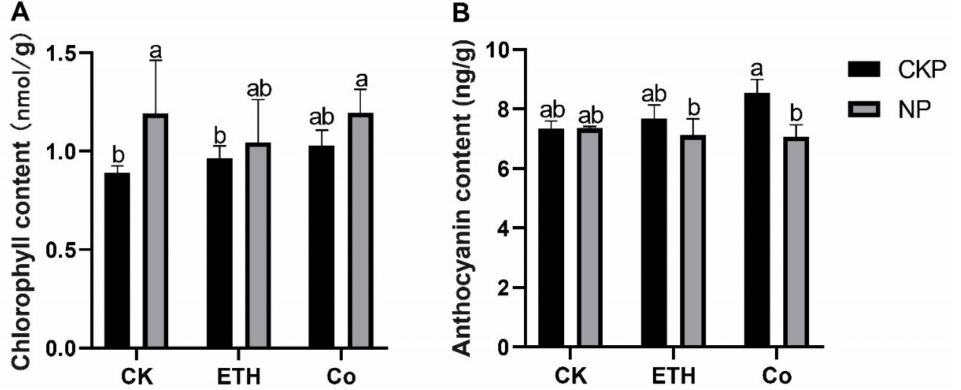
Figure 1. Y -axis represents content, and X -axis represents each treatment group. Gray is normal phos- phate (Pi), black is Pi starvation, CK represents no additional addition, ETH represents the addition of ethephon under phosphorus (P) treatment, Co represents the addition of CoCl 2 under P treat- ment. Small letters indicate significant differences between the different additives under phosphorus stress. ( A ) Chlorophyll content of Chinese fir seedlings under P and exogenous ethylene treatment. ( B ) Anthocyanin content of Chinese fir seedlings under P and exogenous ethylene treatment.